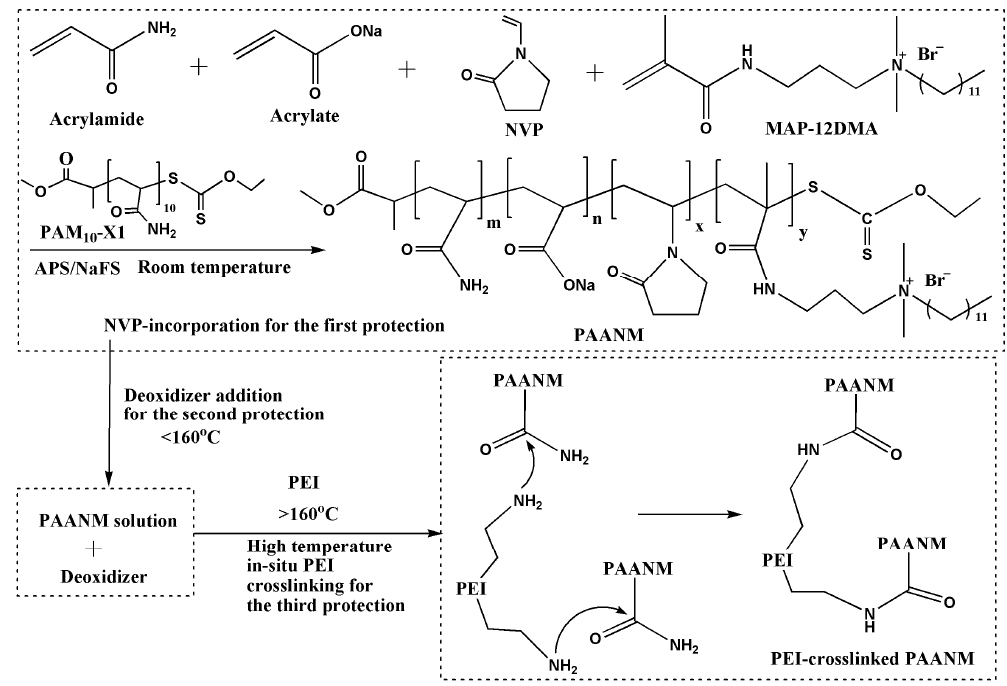
Figure 2. Schematic of the synthesis of N -vinyl-2-pyrrolidone (NVP)-incorporated HAWSPs (named as PAANM) by redox-initiated aqueous polymerization where the rigid moiety NVP works as the first protection to limit thermal motion in HAWSPs, followed by the addition of environmentally-friendly deoxidizer into the polymer solution as the second protection, and polyethyleneimine (PEI) as a crosslinking agent to react with amide groups to form covalent bonds at high temperature in HAWSPs as the third protection.